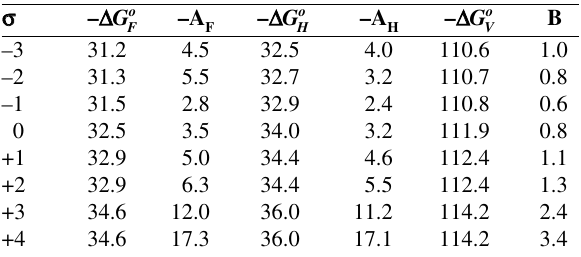
Table 1. The constants of Frumkin (F), corrected Flory-Huggins (H) and virial (V) isotherms for the system: 1 mol/L NaClO